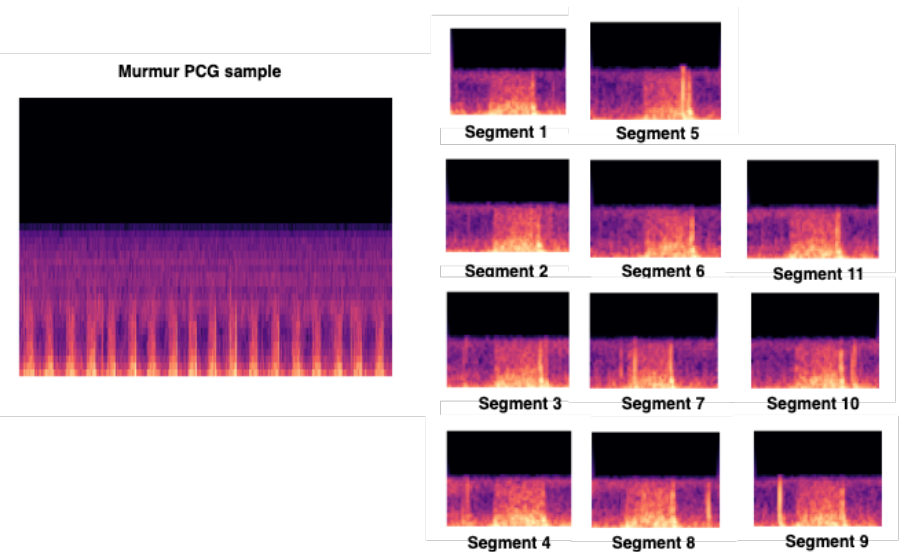
Figure 7. Overview of our CNN input training images issued from preprocessing